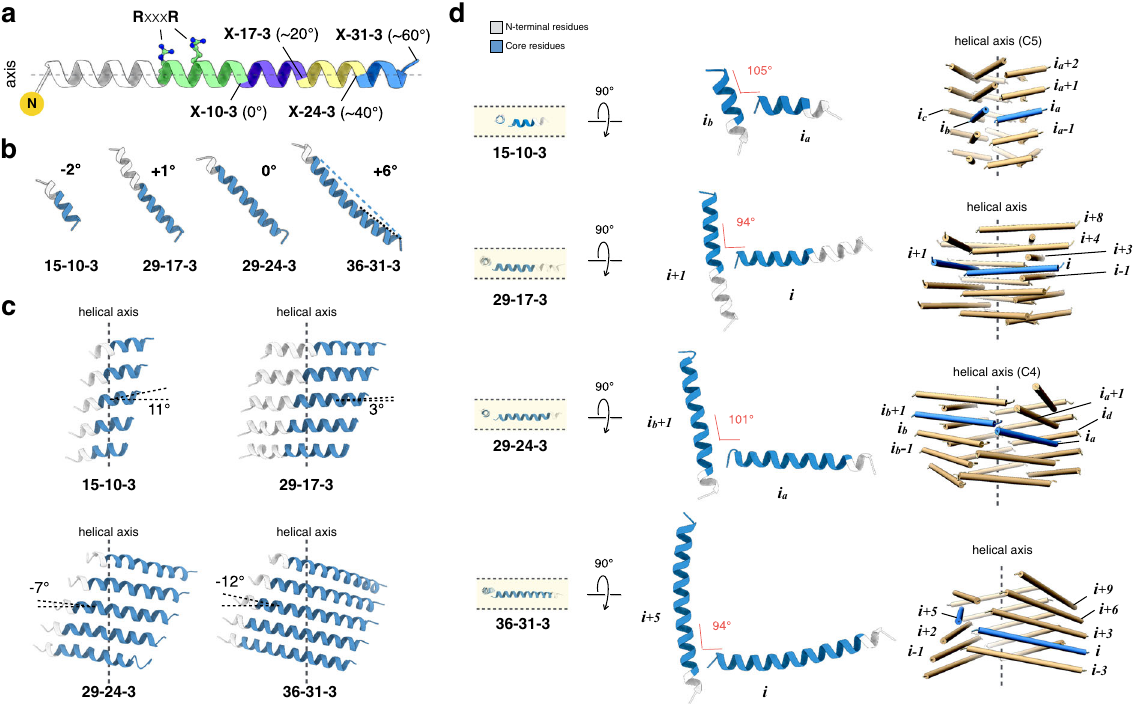
Fig. 4 Three degrees of freedoms to maintain the conserved arginine clasp contacts. a The building blocks of four types of peptide fi laments. The N- terminal residues not involved in fi lament packing are colored white. The RxxxR motif is highlighted. The core region of X-10-3 peptide is colored in green. The core region of X-17-3, X-24-3, and X-31-3 have one (magenta), two (yellow) or three (blue) additional heptads, respectively. b The helix tilt angle of the core region in four types of peptide fi laments. c The cross- α stack within the respective proto fi laments, indicating tilt angle from the plane normal to the helical axis. d Two adjacent helices that make the key contacts in these peptide fi laments. The adjacent helices are oriented to be in the same plane (left), and the angle between the two helices are indicated (middle). The relative positions of these two adjacent helices (blue) in the fi laments are shown